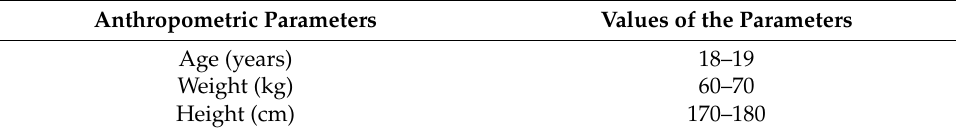
Table 1. Anthropometric parameters of the participants. Anthropometric Parameters Values of the Parameters Age (years) 18–19 Weight (kg) 60–70 Height (cm)